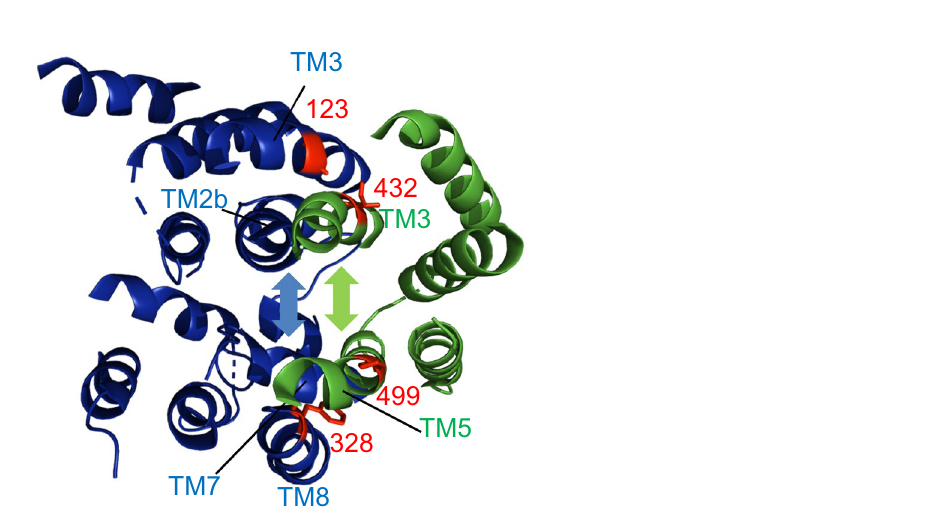
Figure 6. Model of a transmembrane complex between the lateral gate of SecY and the hydrophobic slide of YidC. The SecY TM1-10 (PDB 3J01) is coloured blue, and the YidC TM2-6 (PDB 3WVF) is coloured green. The residues of SecY (G123 and F328) contacting YidC (I432 and P499) are in red. The TM of the lateral gate (SecY- TM2b, 3, 7 and 8, blue arrowhead) interacts with the hydrophobic slide (YidC TM3 and 5, green arrowhead). Therefore, the pore of SecY and the hydrophilic groove of YidC could form an extended cavity for hosting a